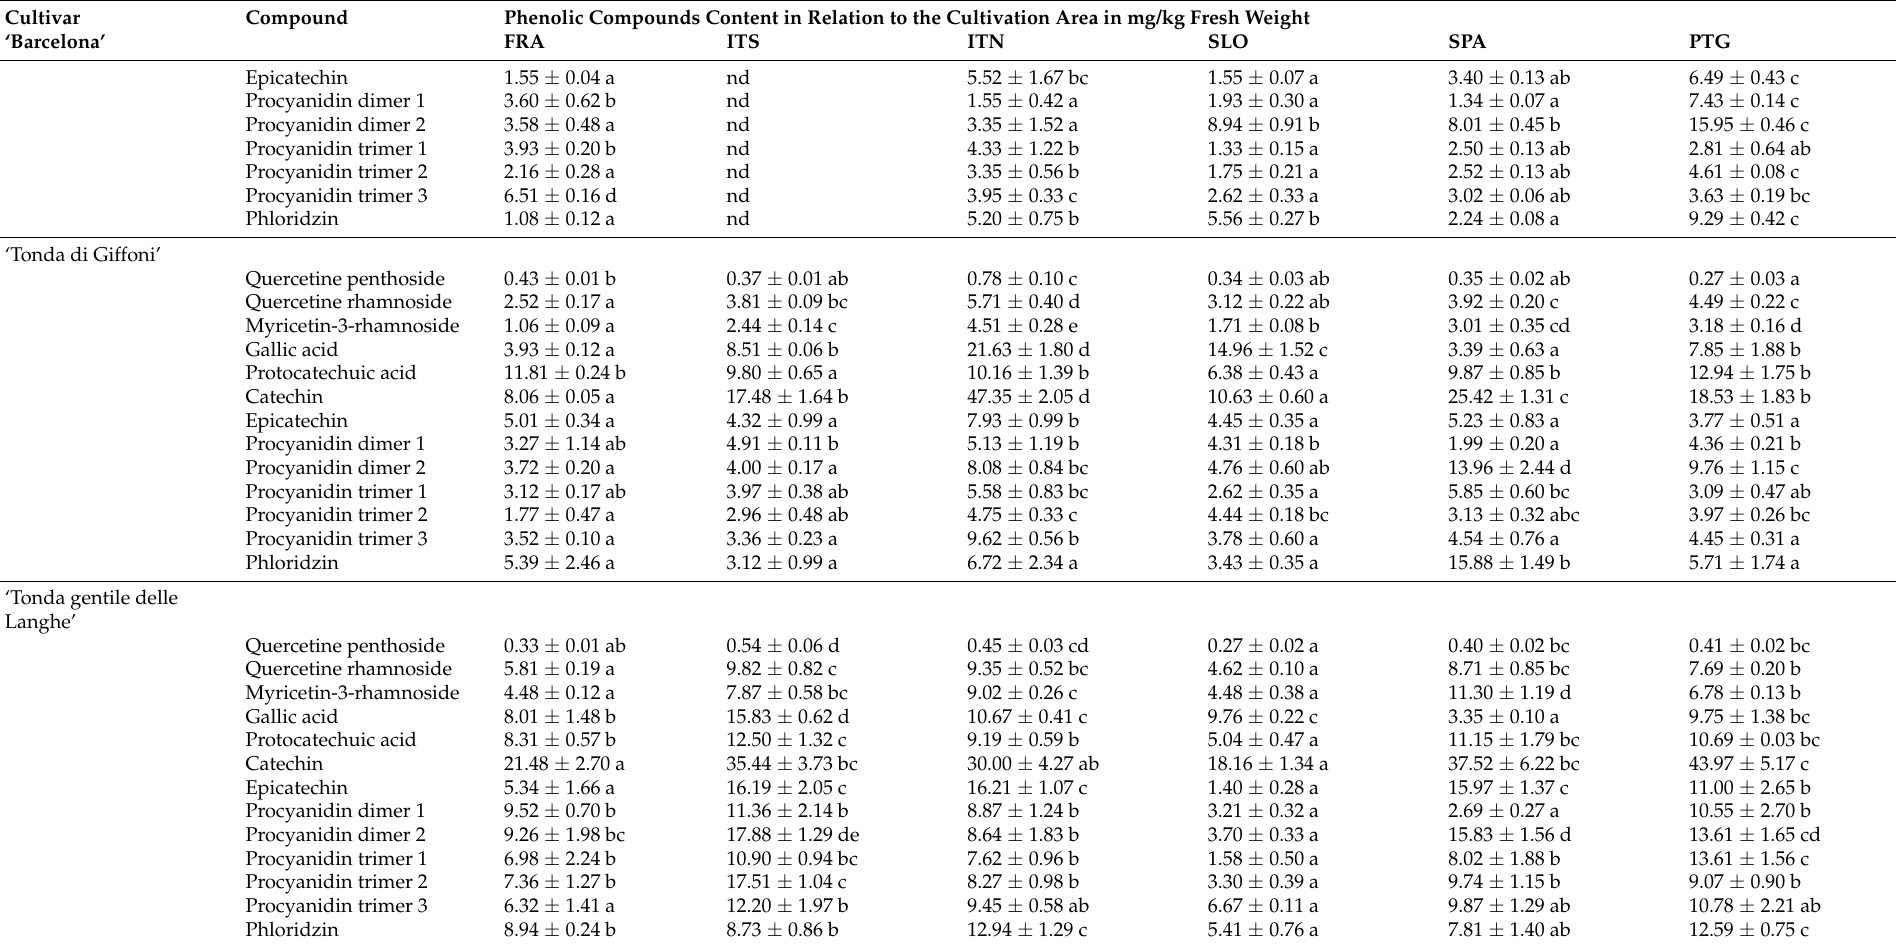
Data are means ± the standard error. Means followed by different letters within rows are significantly different ( p < 0.05). Note: nd, no data; FRA, France; ITS, south Italy; ITN, north Italy, SLO, Slovenia; SPA, Spain; PTG,